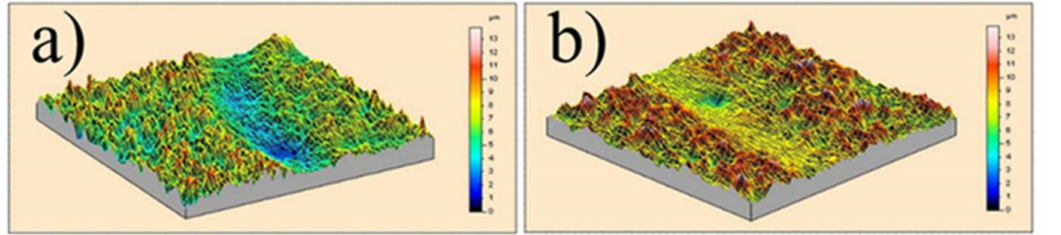
Figure 10. Section of the wear track profile of the Ni–W/B coating prepared at a frequency of 100 Hz and different duty cycles: ( a ) 70% and ( b )